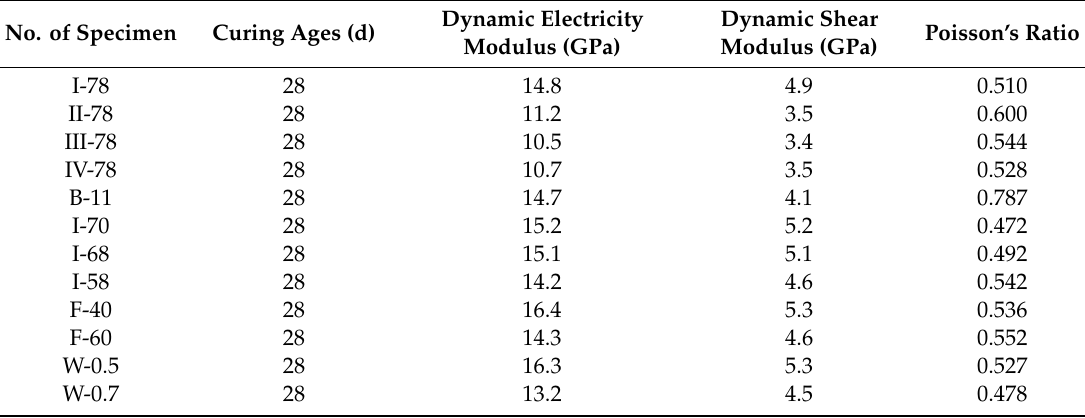
Table 4. Dynamic modulus and Poisson’s ratio results of four series of